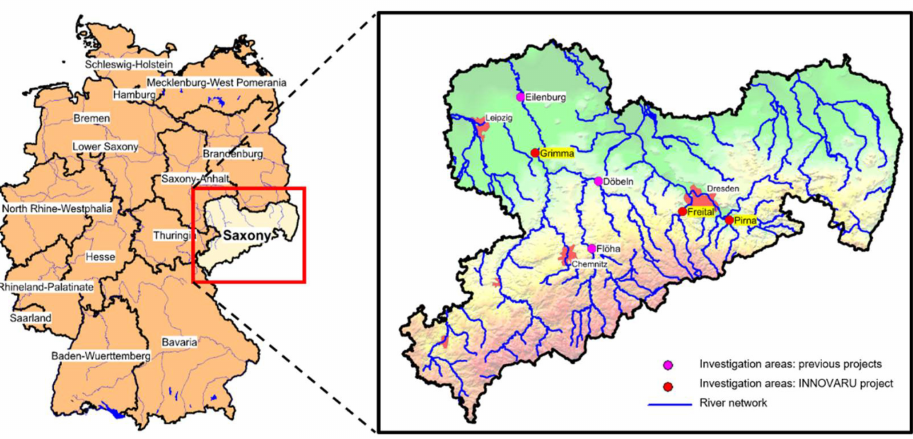
Figure 1. Investigation areas in the Free State of Saxony (cf.